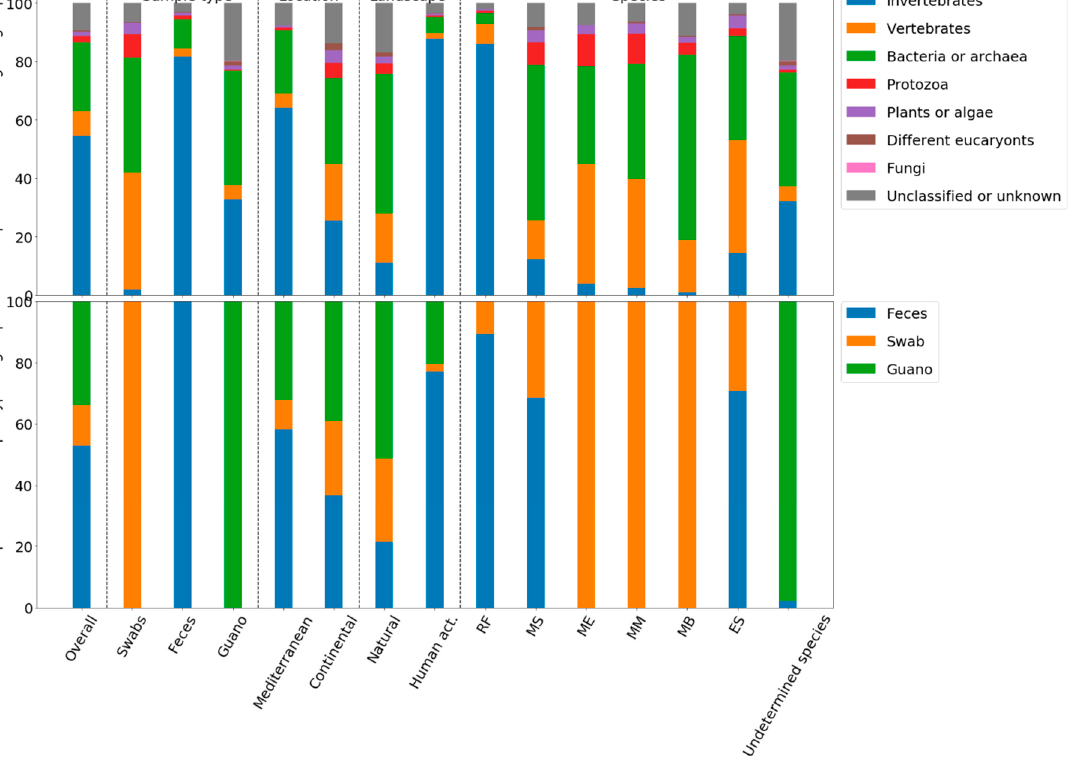
Figure 4. Compositions of samples according host range of classified viral sequences. Samples were grouped according to different attributes (left to right): overall, sample type, location, natural/anthropogenic landscape, bat species.